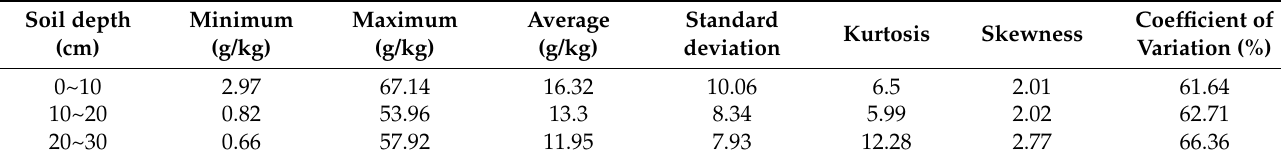
Table 5. SOC content statistics for different soil depths. Table 4. SOC content statistics for farmland and forest.